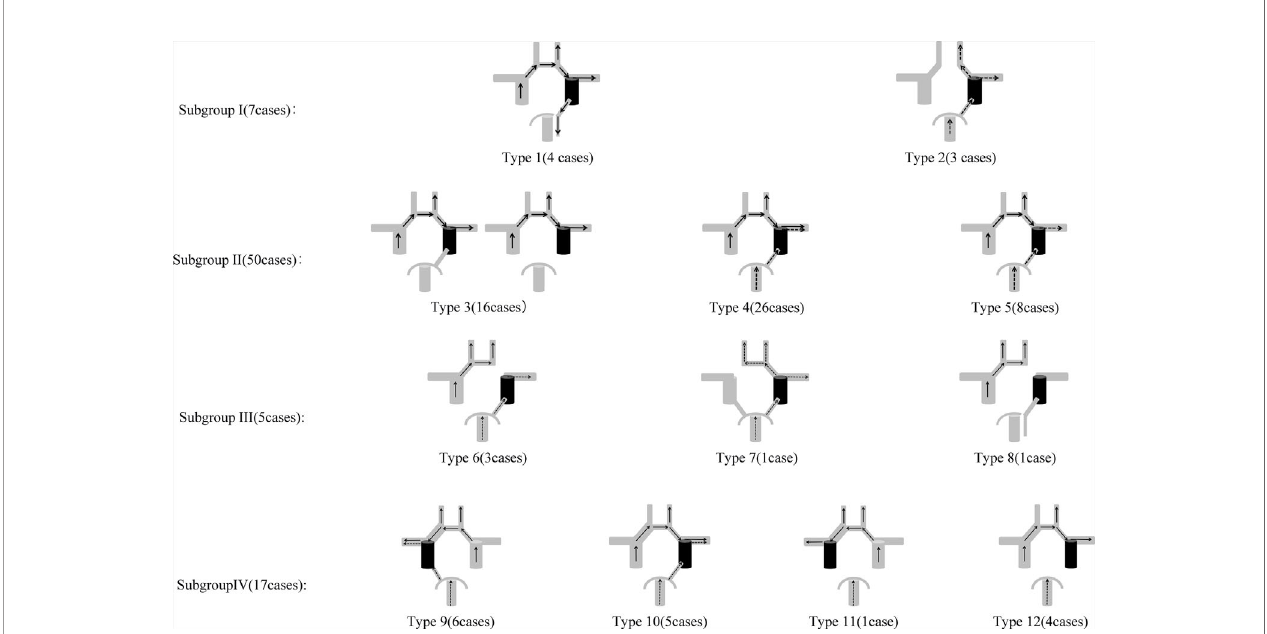
FIGURE 1 | Anatomic Con fi gurations and Collateral Flow Con fi gurations included in this study. Subgroup I: Type 1: A1 to A2 fl ow dominance: symmetric, cfPCA ipsilateral to tested side; Type 2: AcomA absence, complete posterior Circle ipsilateral to tested side. Subgroup II: A1 to A2 fl ow dominance: symmetric. Type 3: Tested side MCA area blood supply: the anterior Circle alone; Type 4: Tested side MCA area blood supply: both the anterior Circle and the posterior Circle; Type 5: Tested side MCA area blood supply: the posterior Circle alone. Subgroup III: A1 to A2 fl ow dominance: complete. Type 6: A1 absence ipsilateral to the tested side; Type 7: A1 absence contralateral to the tested side; Type 8: A1 absence ipsilateral to the tested side, cfPCA ipsilateral to tested side. Subgroup IV: A1 to A2 fl ow dominance: dominant. Type 9: A1 dominance ipsilateral to the tested side, complete posterior Circle on tested side; Type 10: A1 dominance contralateral to the tested side, complete posterior Circle on tested side; Type 11: A1 dominance ipsilateral to the tested side, PcomA absence on tested side; Type 12: A1 dominance contralateral to the tested side, PcomA absence on tested